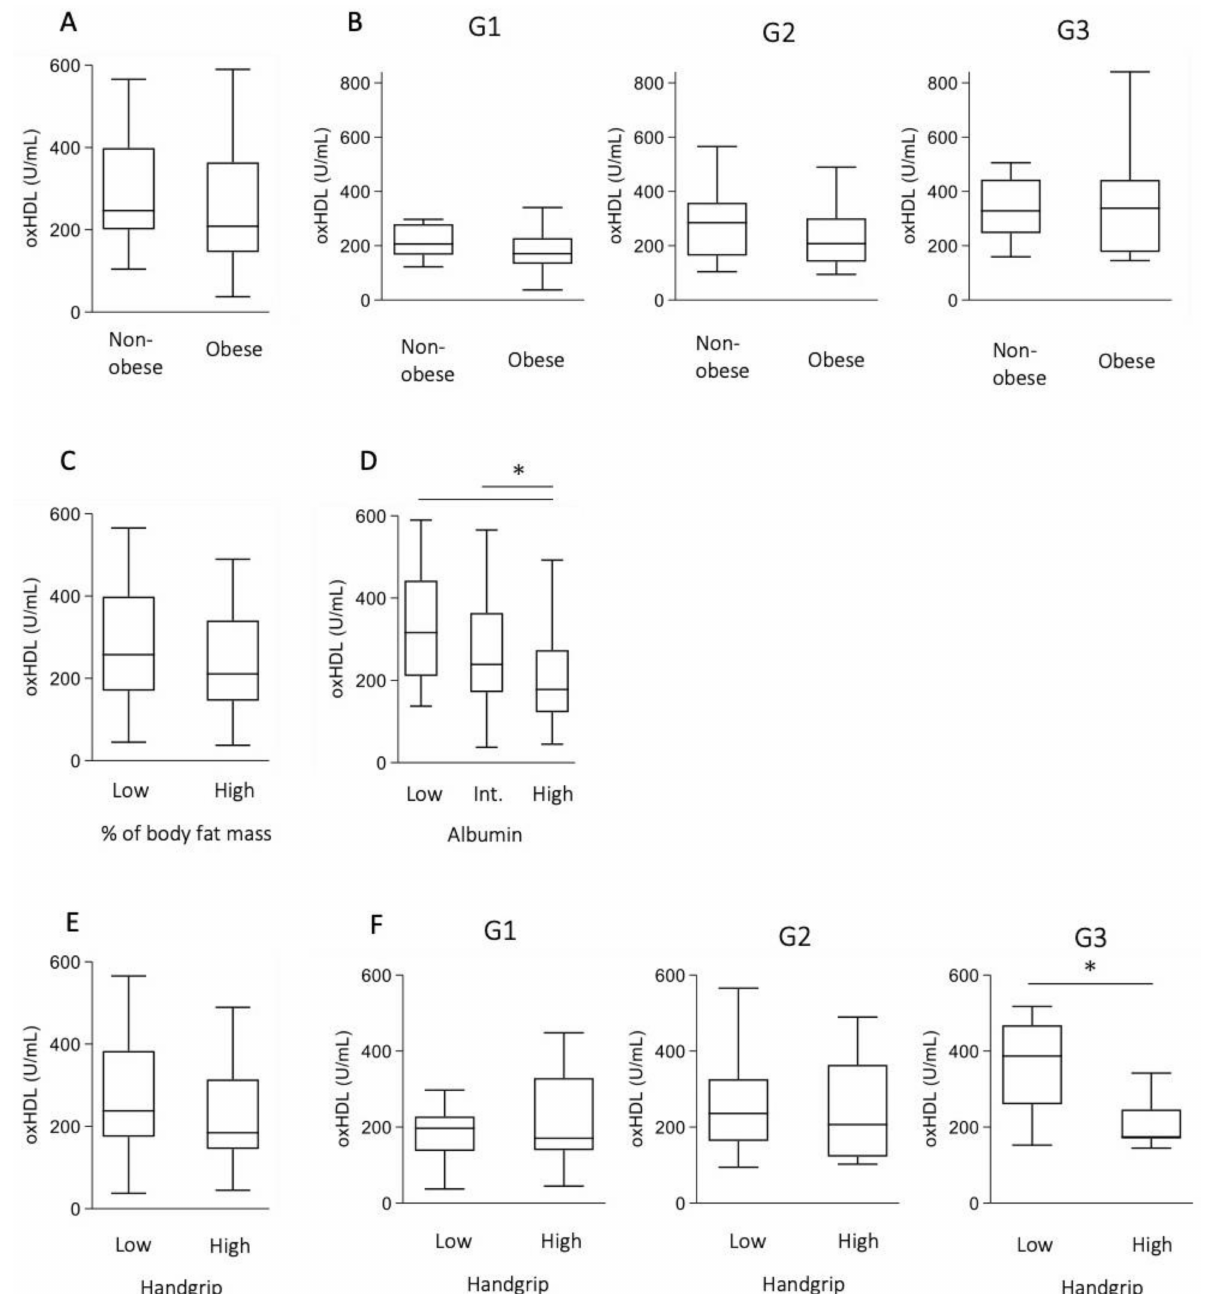
Figure 4. oxHDL levels in patients with NAFLD. ( A ) Non-obese ( n = 33) versus obese individuals ( n = 73). ( B ) Non-obese versus obese individuals in each fibrosis grade defined by the FIB-4 index. G1, Non-obese ( n = 19) versus obese individuals ( n = 27); G2, Non-obese ( n = 7) versus obese individuals ( n = 30); G3, Non-obese ( n = 9) versus obese individuals ( n = 16). ( C ) Individuals with low ( n = 37) versus high percentage of body fat mass ( n = 67). High percentage of body fat mass was defined >30% in men and >35% in women. ( D ) Low ( n = 26) versus intermediate ( n = 51) versus high albumin group ( n = 29). Albumin concentrations in each group were <4.1, 4.1–4.5, <4.5 g/dL, respectively. ( E ). Low ( n = 72) versus high handgrip strength ( n = 28). ( F ) Low versus high handgrip strength in each fibrosis grade defined by the FIB-4 index. G1, low ( n = 27) versus high ( n = 16); G2, low ( n = 26) versus high ( n = 8); G3 low ( n = 19) versus high ( n = 4). * p <